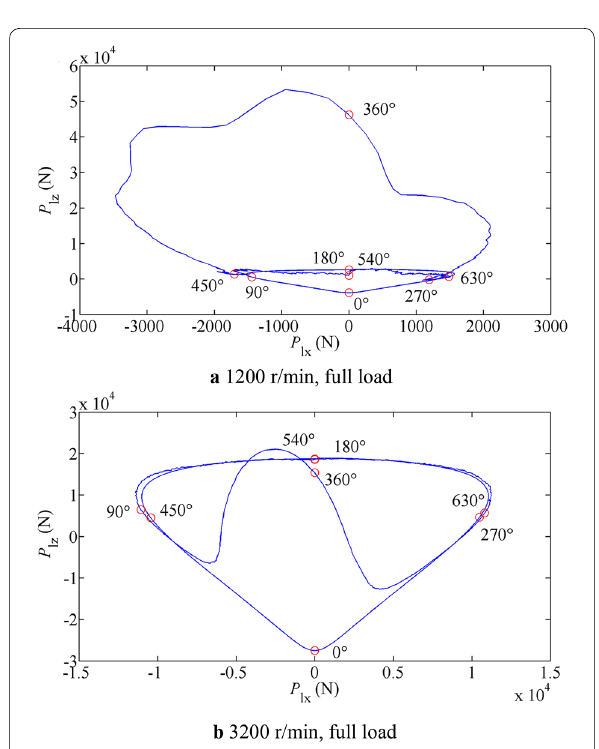
Figure 3 Load of connecting-rod bearing